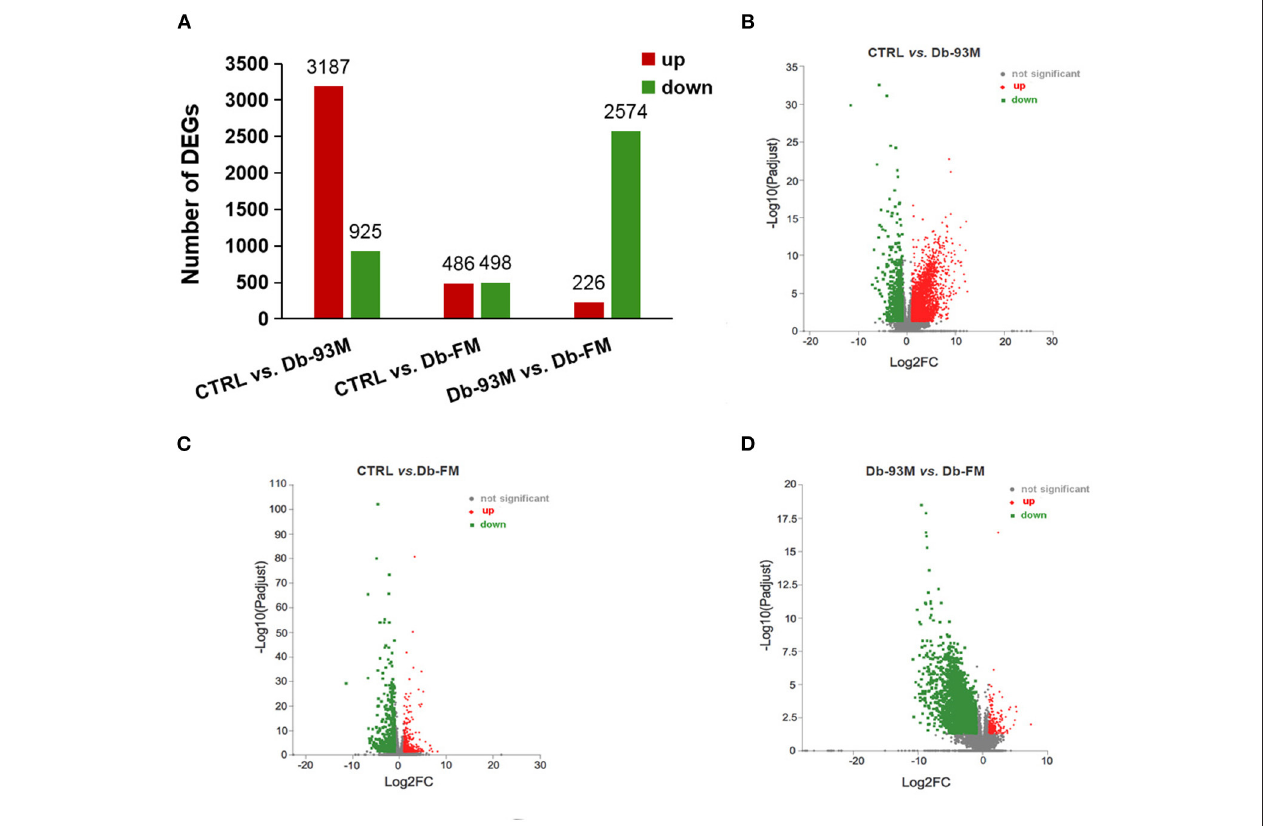
FIGURE 3 | The gene expression analysis performed by RNA-sequencing (RNA-Seq, n = 6). (A) Numbers of differential expressed genes (DEGs) in kidney tissue of different groups; the volcanic maps for DEGs in (B) CTRL vs. Db-93M group; the red dots were up-regulated, and the green dots were down-regulated in Db-93M group when compared to CTRL group. (C) CTRL vs. Db-FM groups; the red dots were up-regulated, and the green dots were down-regulated in the Db-FM group when compared to the CTRL group. (D) Db-93M vs. Db-FM group; the red dots were up-regulated, and the green dots were down-regulated in the Db-FM group when compared to the Db-93M group.